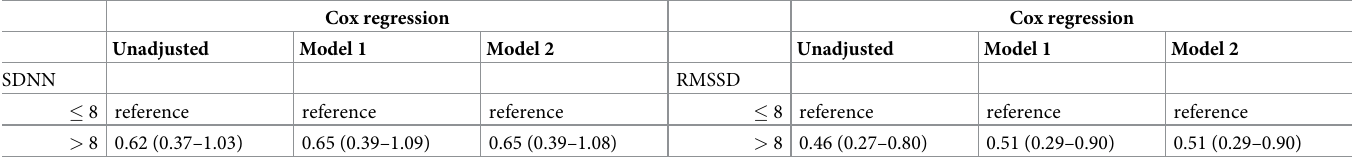
Table 4. Hazard ratio for ICU admission within three weeks after admission.